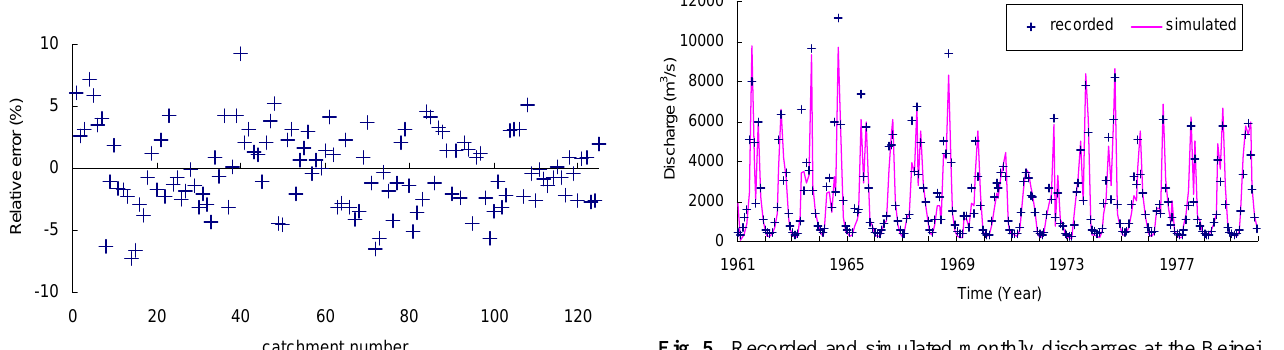
Fig. 5. Recorded and simulated monthly discharges at the Beipei station in the Yangtze River basin, with a drainage area of 156,142km 2 (NSE = 92.4%, RE = -3.7%)